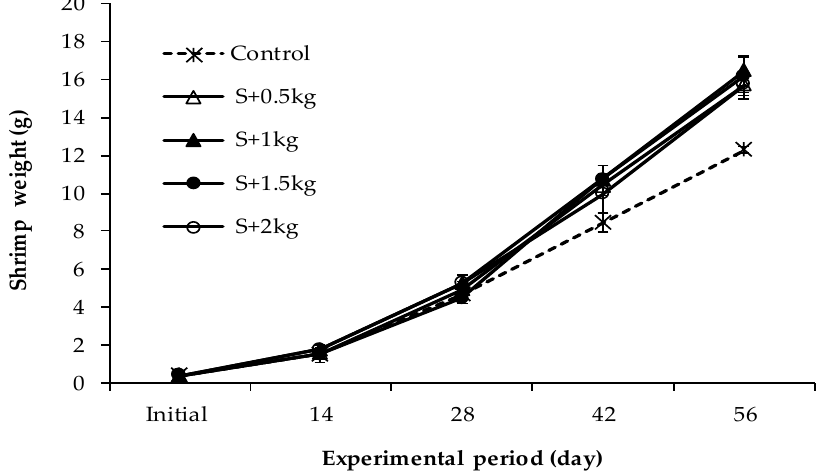
Figure 5. Variation in shrimp weight in polyculture with sea grape during the culture duration. Furthermore, the growth rate of shrimps in terms of weight gain (WG) and daily weight gain (DWG) and specific growth rate (SGR W ), and the specific growth rate in length (SGR L ) of the shrimps followed the same pattern as that observed for the final weight and length. Statistical analysis of the growth performance of the shrimp found that control treatment significantly differed from polyculture groups (Table 4). Although the shrimp growth rate was relatively higher in the S + 1 kg group than in the other integrated treatments, there were no significant differences among these treatments (Table